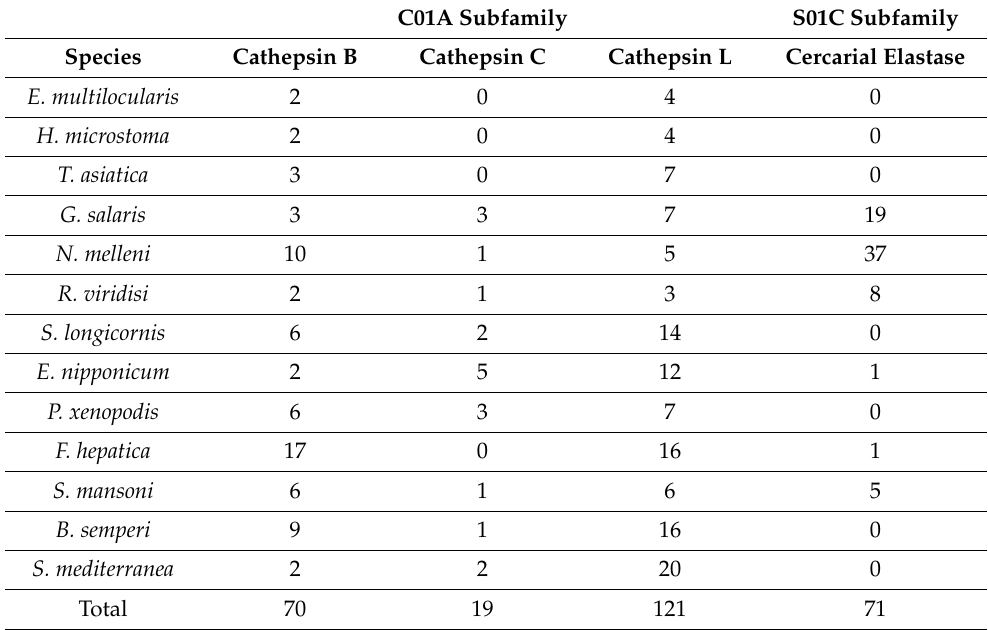
Table 2. Main members of the C01A and S01C subfamilies are classified in the phylogenetic